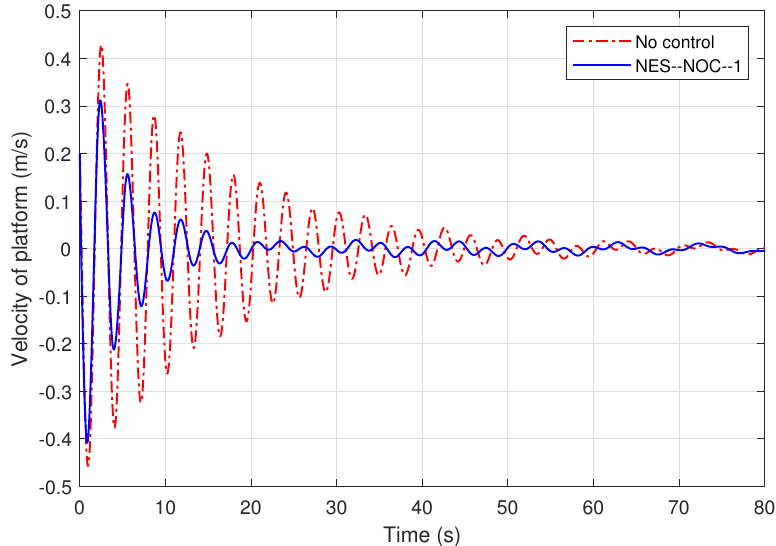
Figure 8. Velocities of the structure with